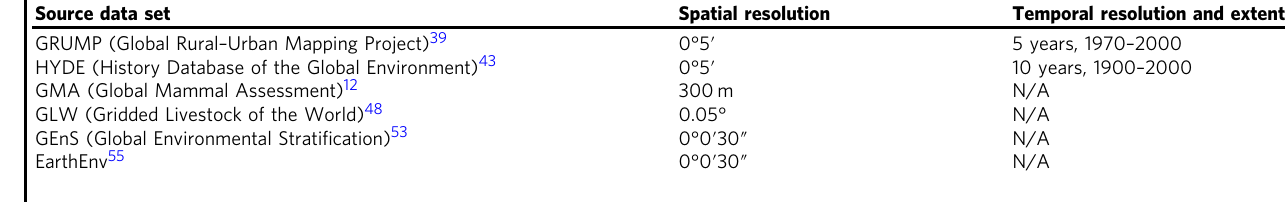
Table 2 Original resolutions and extents of source data sets Source data